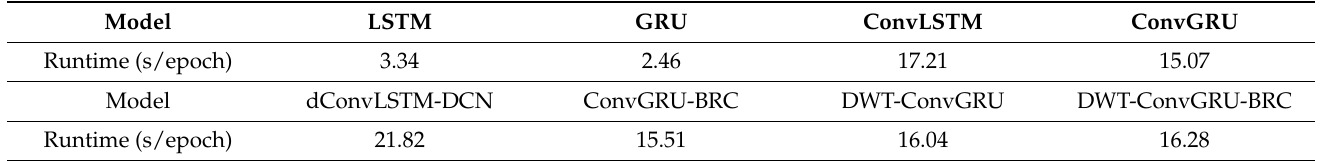
Table 4. GPU runtimes of different prediction